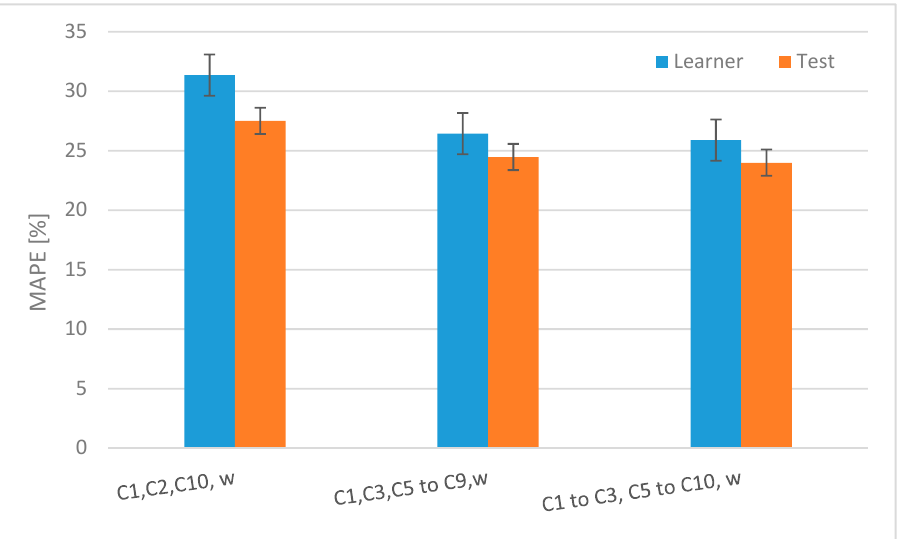
Figure 6. Assessment of the quality of the developed models of the total waste accumulation indicator based on studied set of input variables (C1 to C10). C1—municipality administrative type; C2— functional structure of communes; C3—population density per ∙ km − 2 ; C5—indicator household size